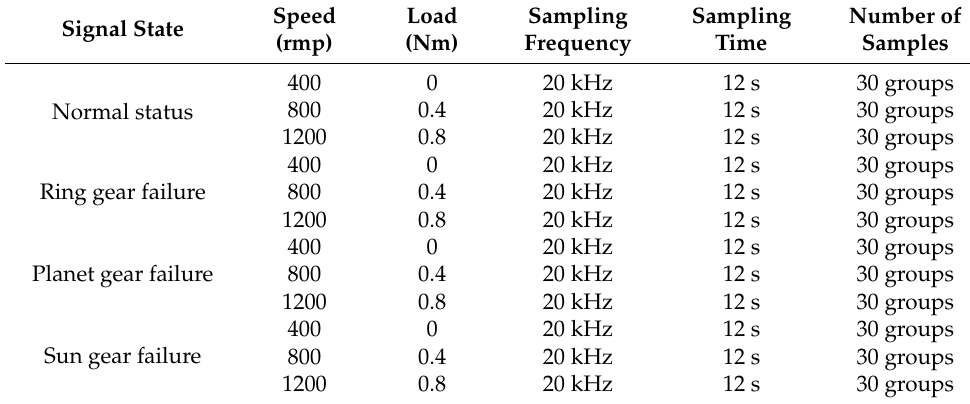
Table 1. Four preset fault datasets under different working